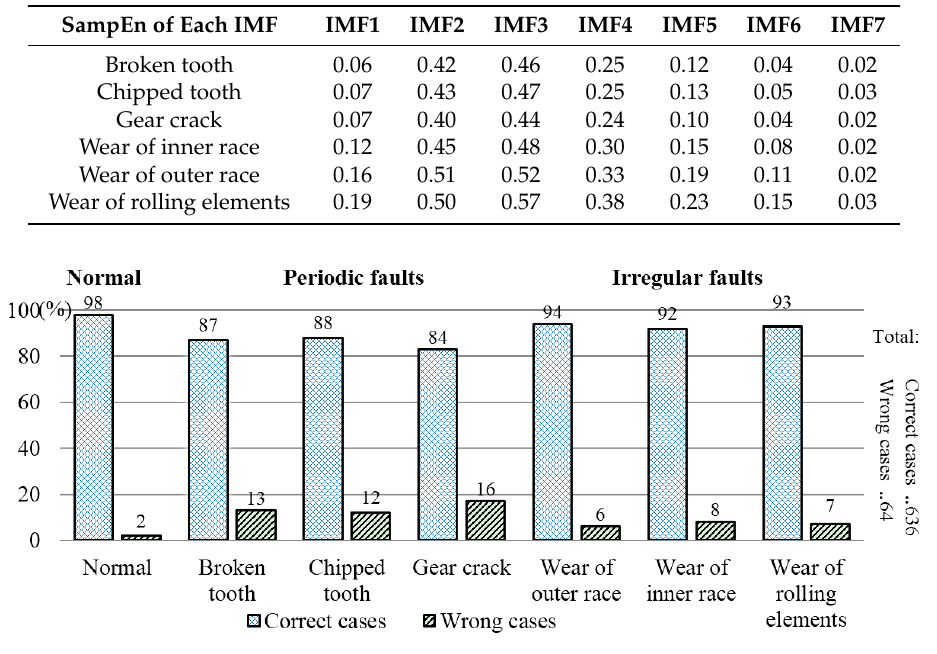
Figure 9. The experiment outcome based on SampEn. Remark: Pattern recognition is based on the proposed method PC-SBELM. Table 7. Results of 12 wrongly classified cases of chipped tooth using SampEn.